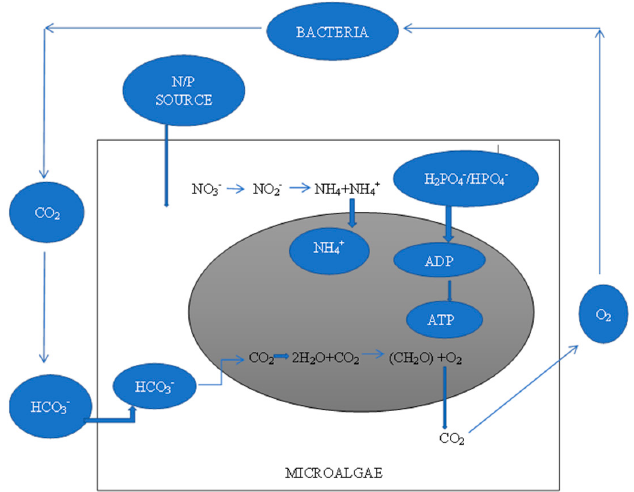
Figure 1. A bacterial-microalgae relationship in wastewater treatment.